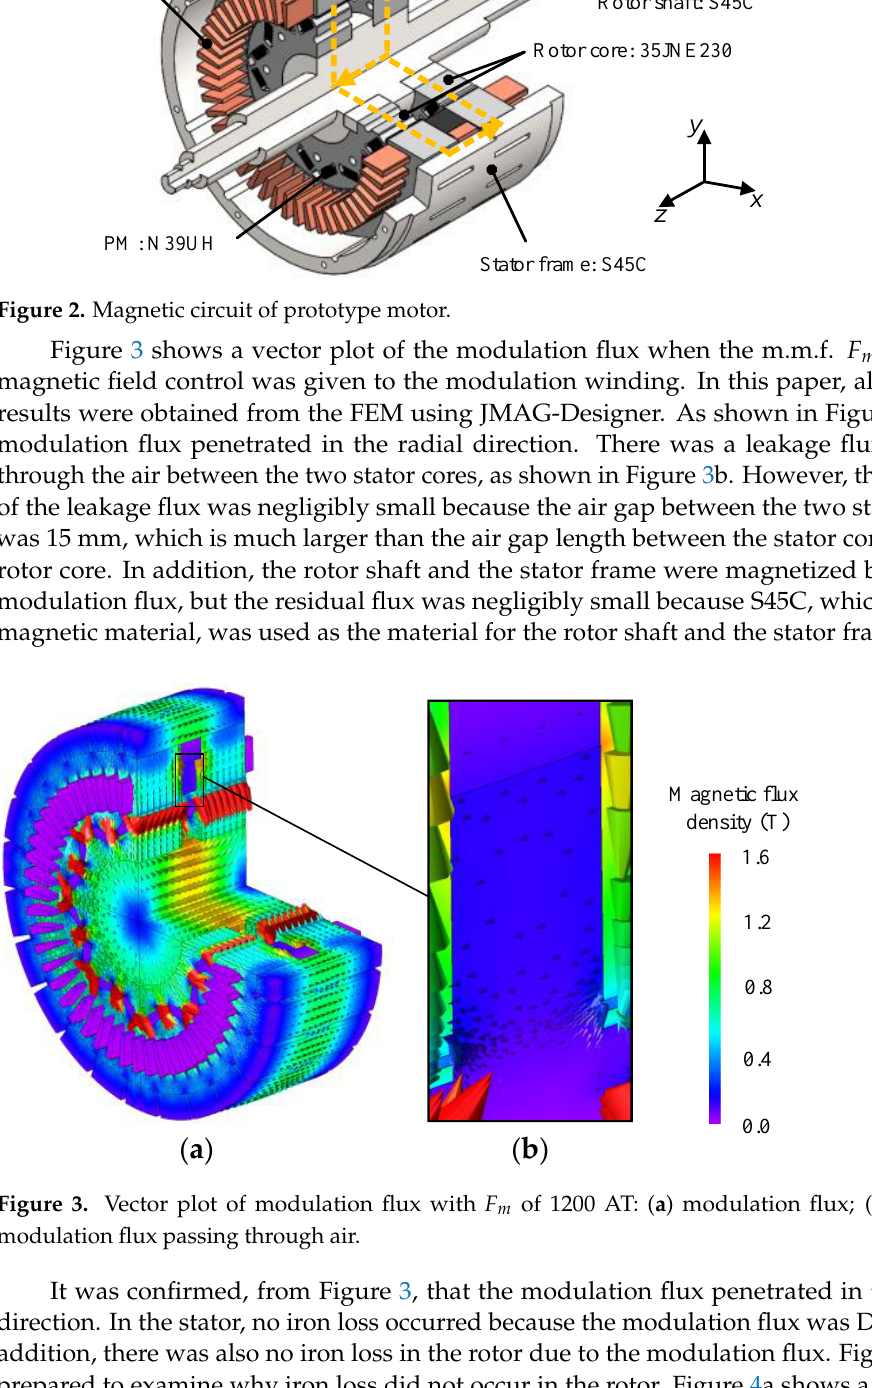
Figure 2. Magnetic circuit of prototype motor. Table 1. Specifications of prototype motor.